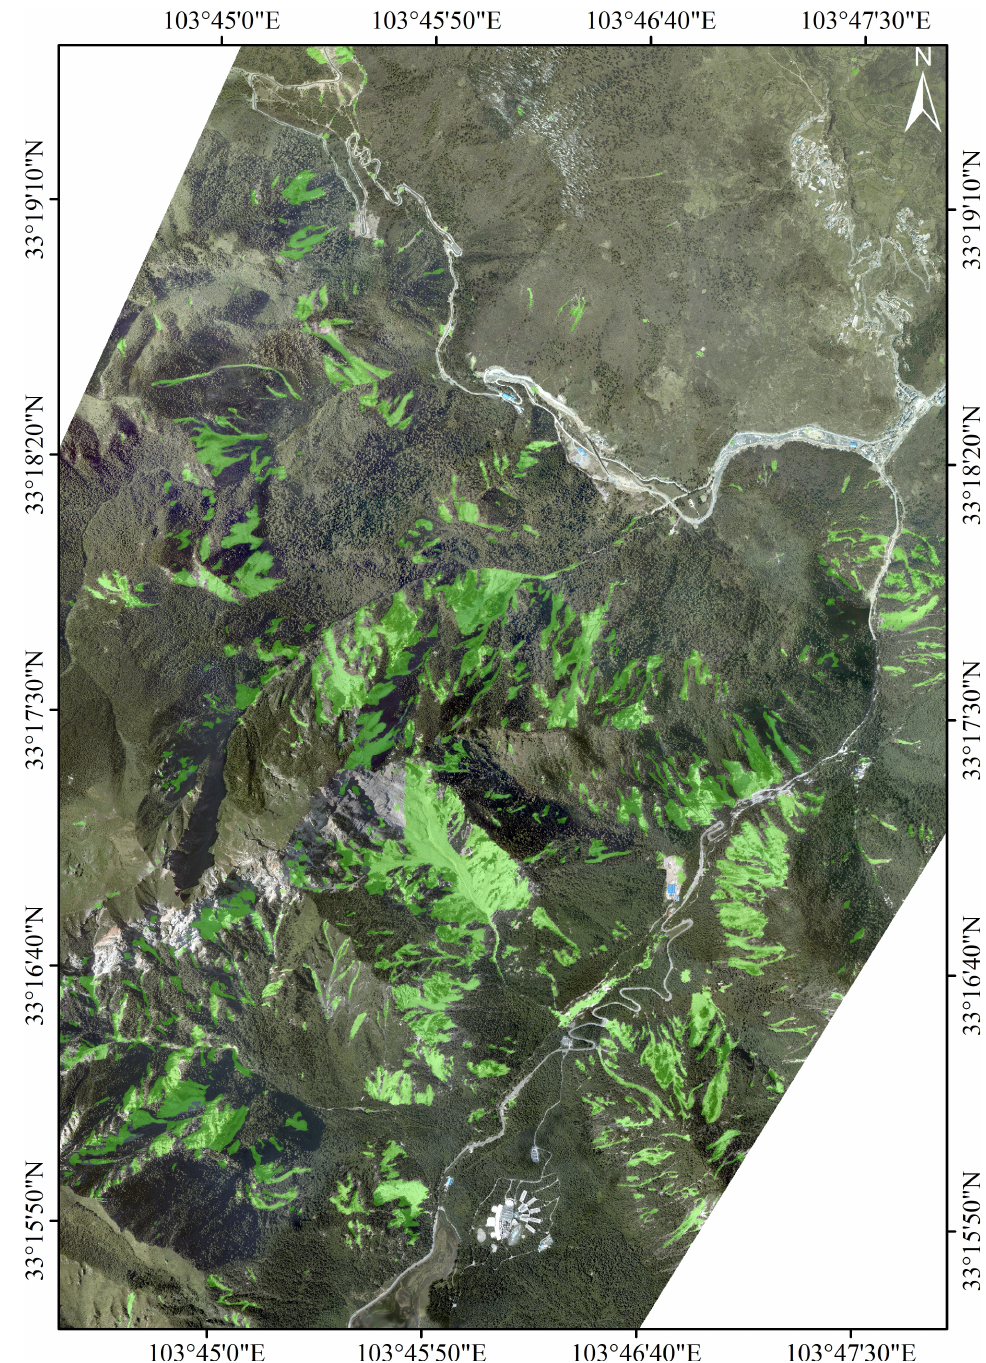
Figure 8. Visualization results of the SegFormer model. Green areas represent the predicted